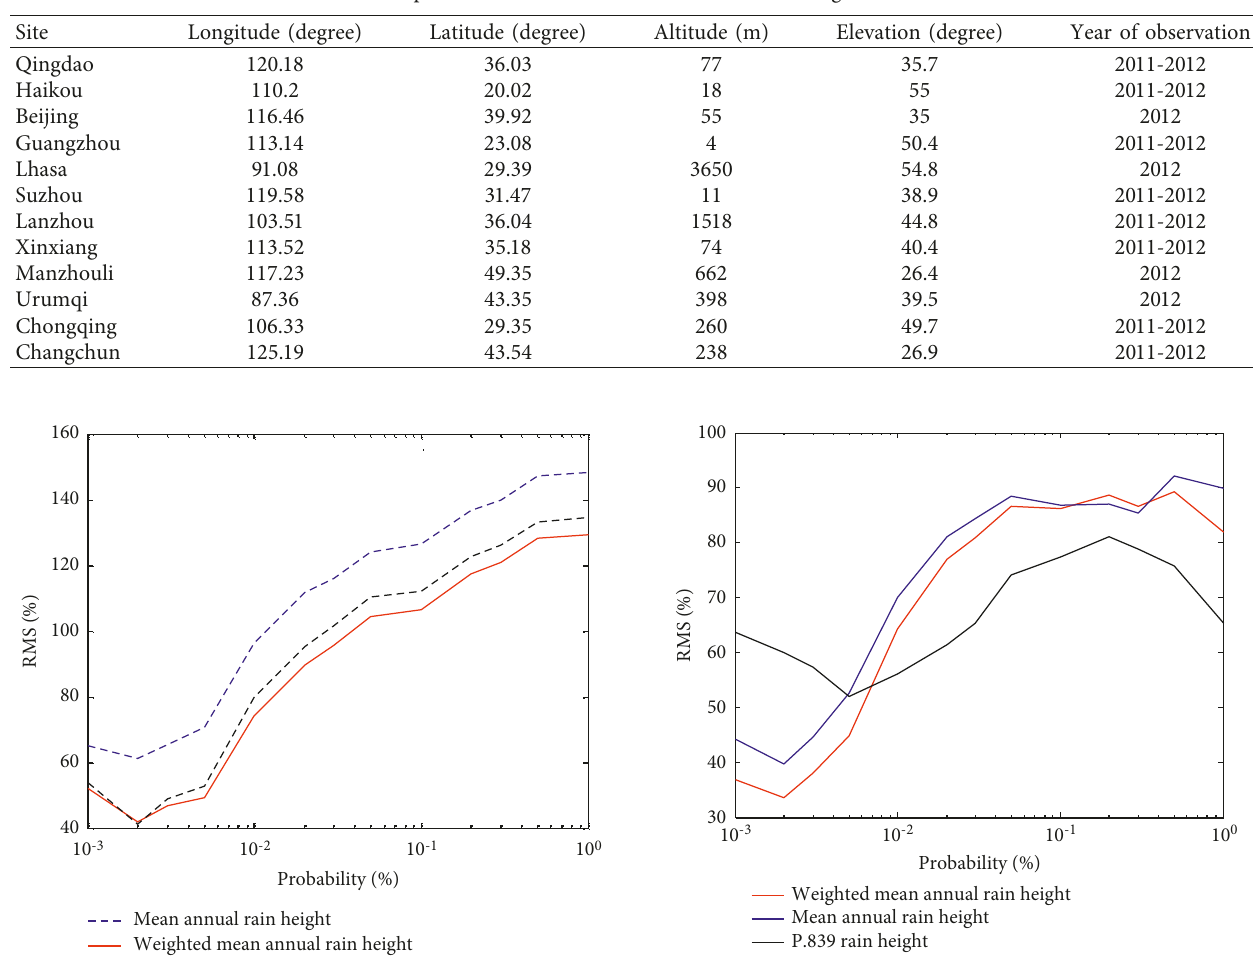
Table 1: The parameters of the radio wave links of the 12 ground stations.